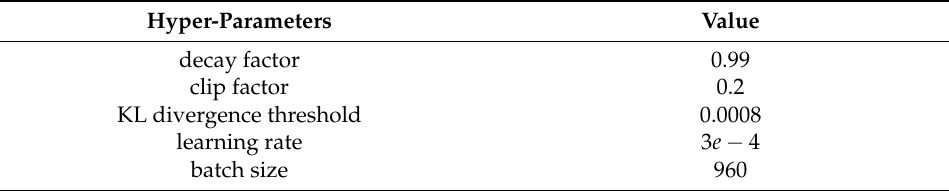
Table 2. Hyper-parameters in Algorithm